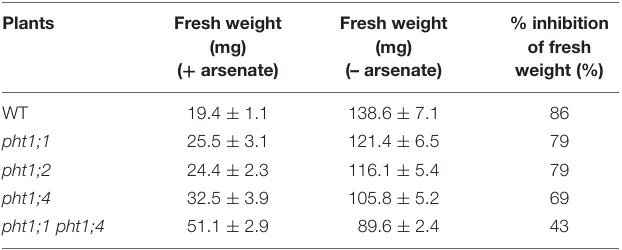
TABLE 2 | Arabidopsis pht1 mutants are more resistant to arsenate (V) than the WT. After 10 days, the seedlings were transferred to MS medium with 1 mM Pi and 200 µ M arsenate.